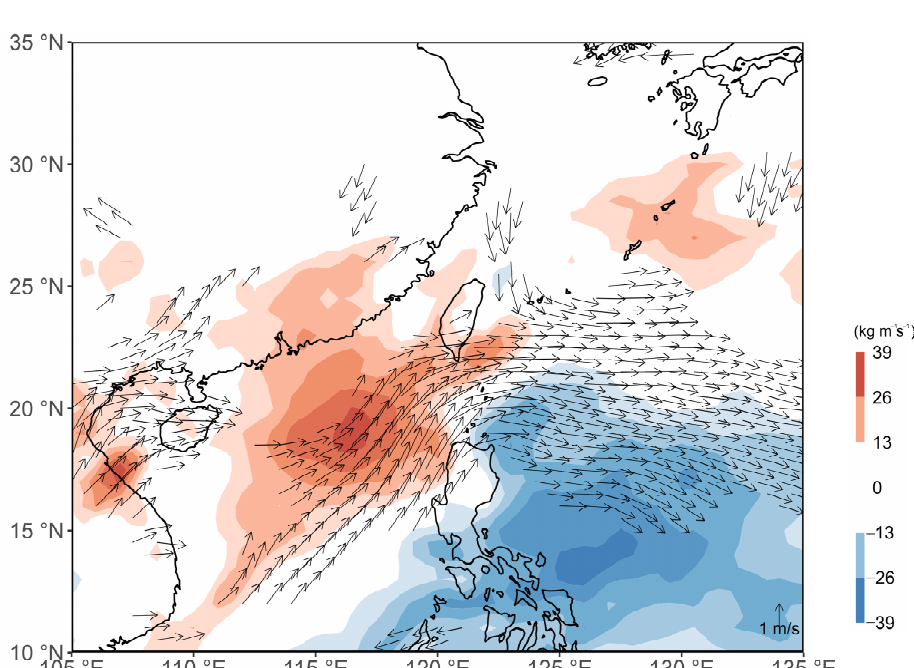
Figure 8. F1-score for EXP-G2D2 from 1990 to 2019.